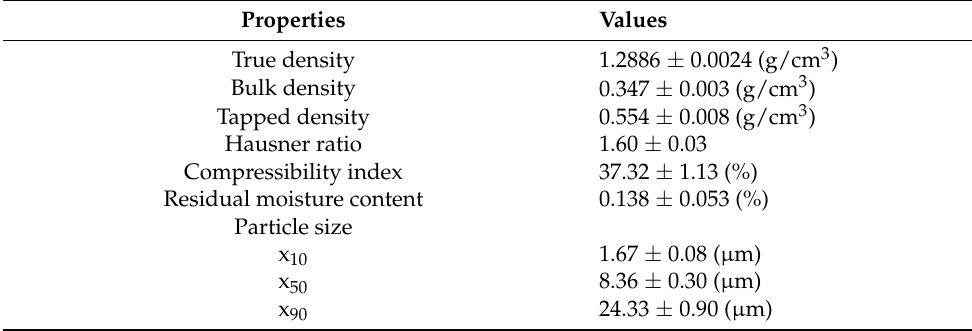
Table 5. Physicochemical properties of the investigated ACAM (means ± SD, n =